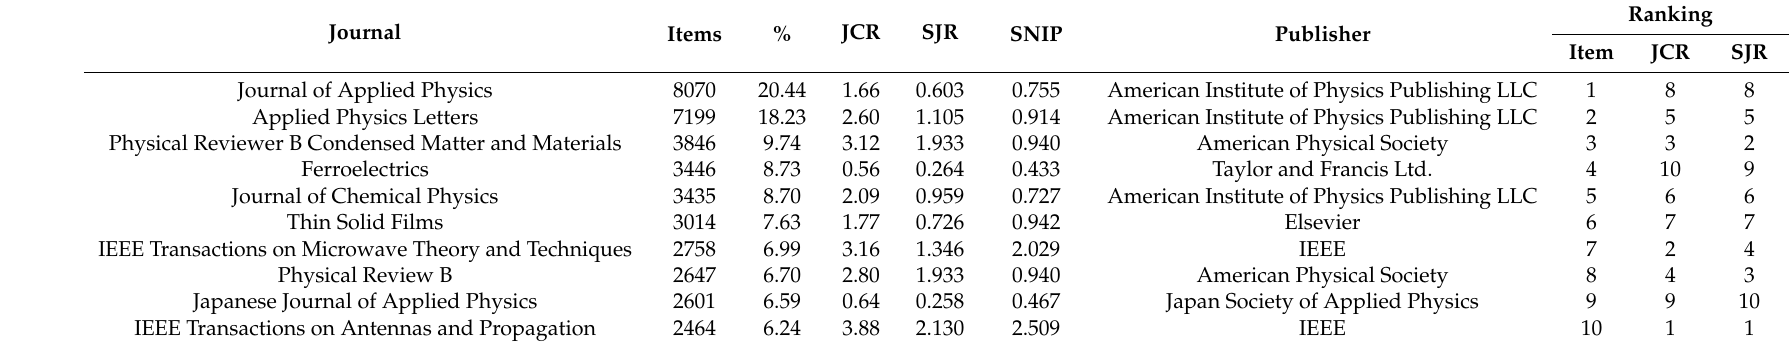
Table 1. Top 10 ranking journals in dielectric.